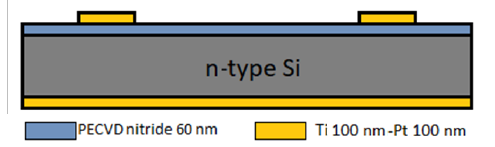
Figure 1. Schematic representation of the substrate cross-section.